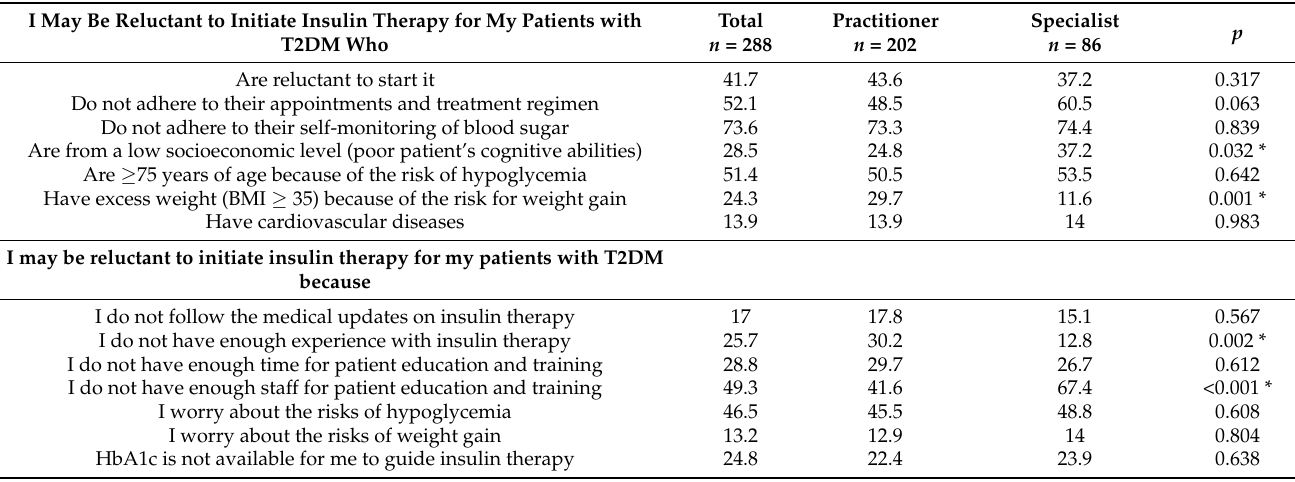
Table 2. Reasons for reluctance to initiate